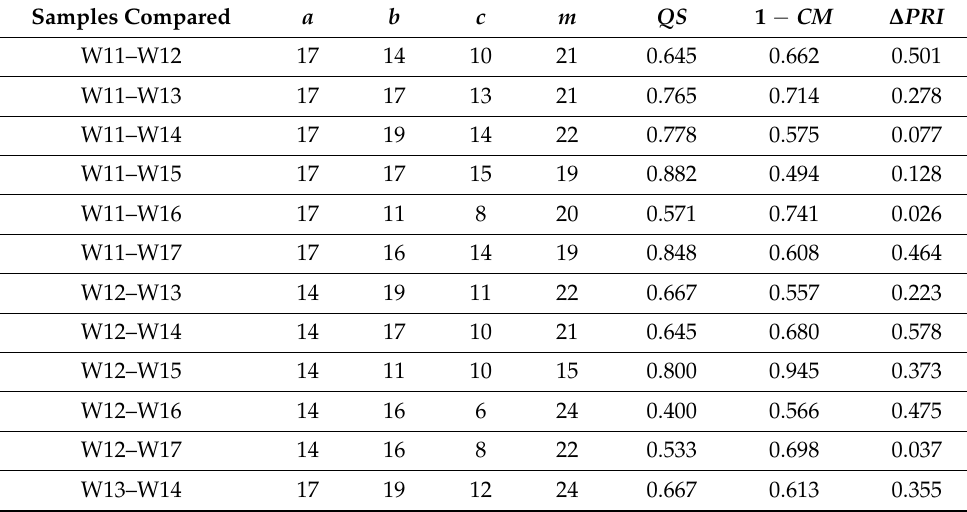
Table A4. Data supporting the case study